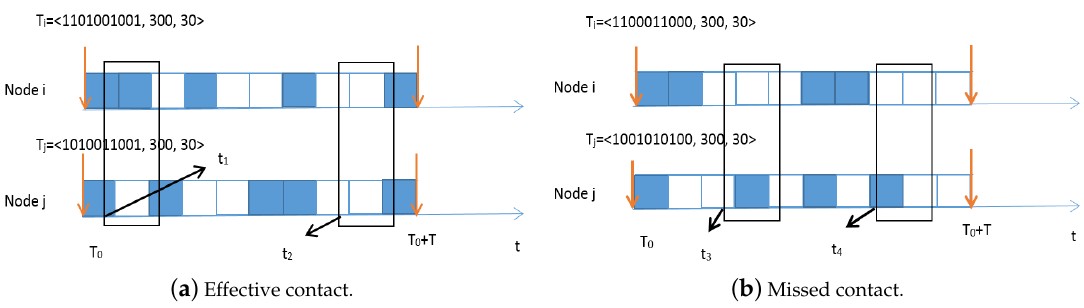
Figure 1. Effective ( a ) and Missed ( b ) Contacts between nodes i and j , where blue slots represent the listening state and the white slots represent the sleeping